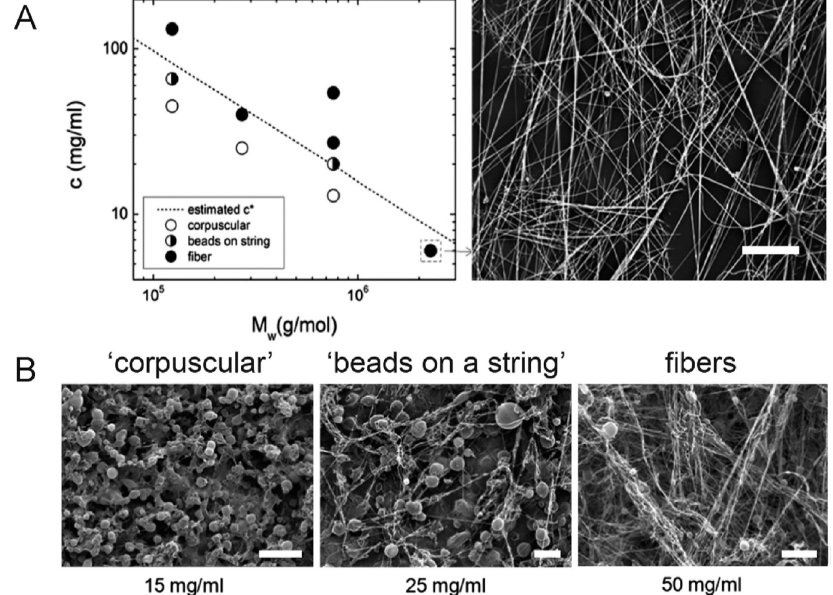
Figure 13. ( A ) Plot indicating morphology of poly(methyl methacrylate) (PMMA) sprayed using a solution blow spinning (SBS) apparatus at various concentrations and molecular weights. The estimated overlap concentration (c *) is indicated by the dashed line. Scanning electron microscopy (SEM) image of PMMA fibers formed at high molecular weight but below overlap concentration. Scale bar represents 50 µm. ( B ) SEM images of 50/50 wt. % PMMA/1H,1H,2H,2H-heptadecafluorodecyl polyhedral oligomeric silsesquioxane (PMMA: Mw = 593 kDa, PDI = 2.69) blends sprayed using an SBS apparatus at increasing concentrations of PMMA in solution. Scale bars represent 50, 100, and 50 µm, respectively [29].